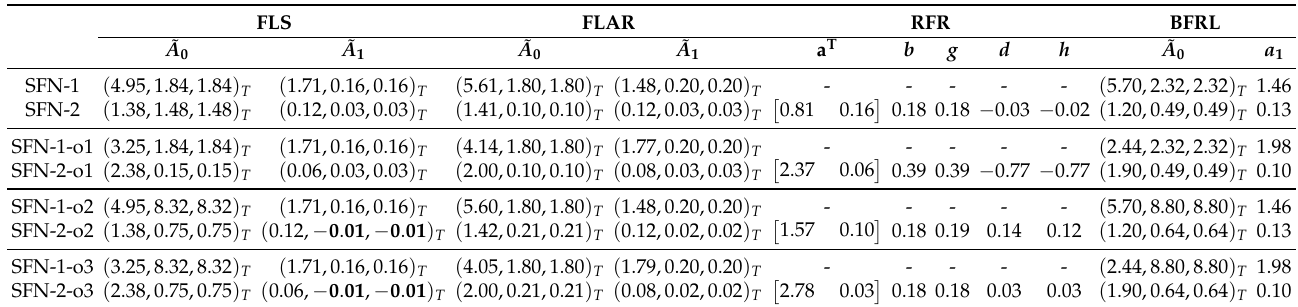
Table 7. Parameters of fuzzy regression models ˜ A 0 , ˜ A 1 , a , b , g , d , h and a 1 estimated by the fuzzy least squares (FLS), the fuzzy least absolute linear regression (FLAR), the robust fuzzy regression (RFR) analysis, and the Boscovich fuzzy regression line (BFRL) on datasets (first column) with symmetric fuzzy observations. Negative spreads are in